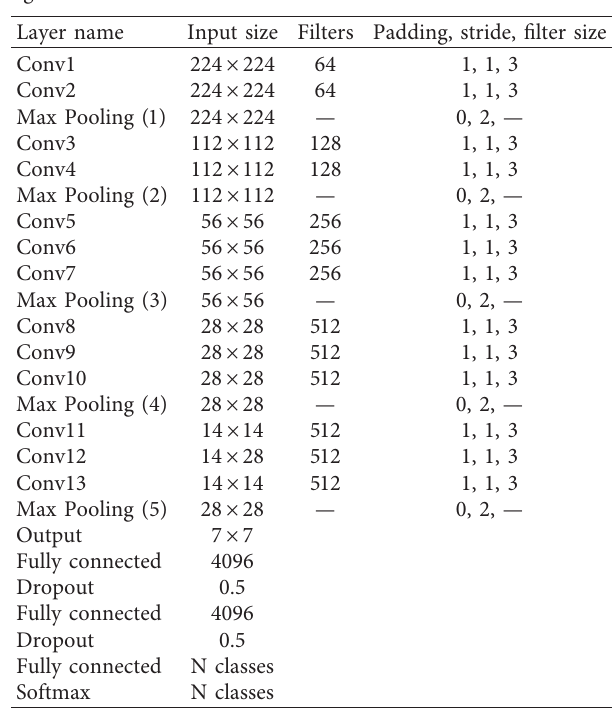
Table 1: Network configuration. Details of VGG face CNN con- figuration where N is the number of